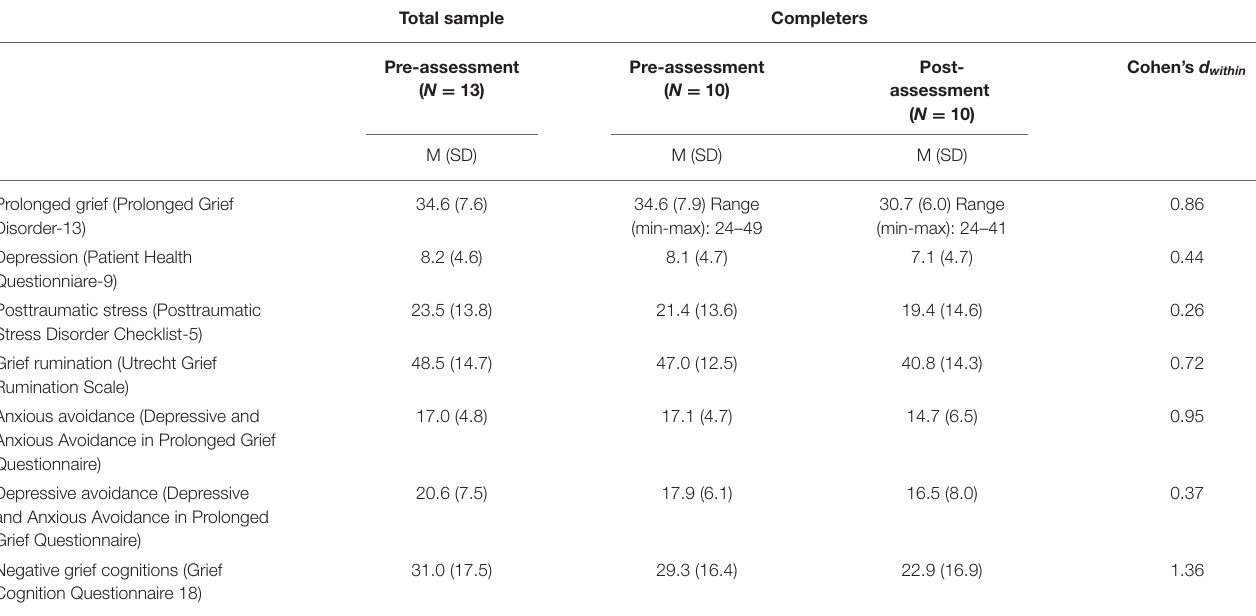
TABLE 2 | Mean scores, Standard deviations (SD) and Effect sizes (Cohen’s d) of within-group differences for the outcome